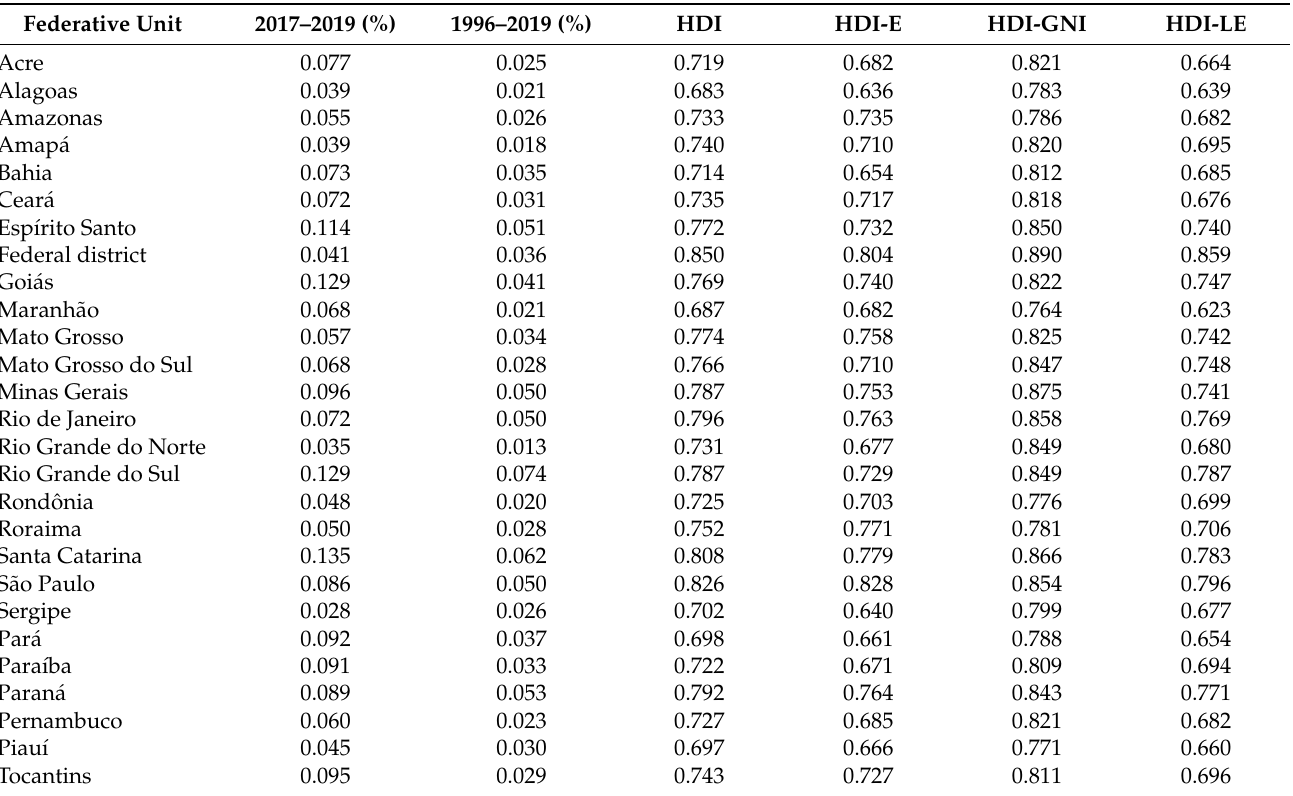
Table 2. Number of death cases from cystic fibrosis and Human Development Index (HDI) per federative units in Brazil according to the Unified National Health System Information Technology Department,